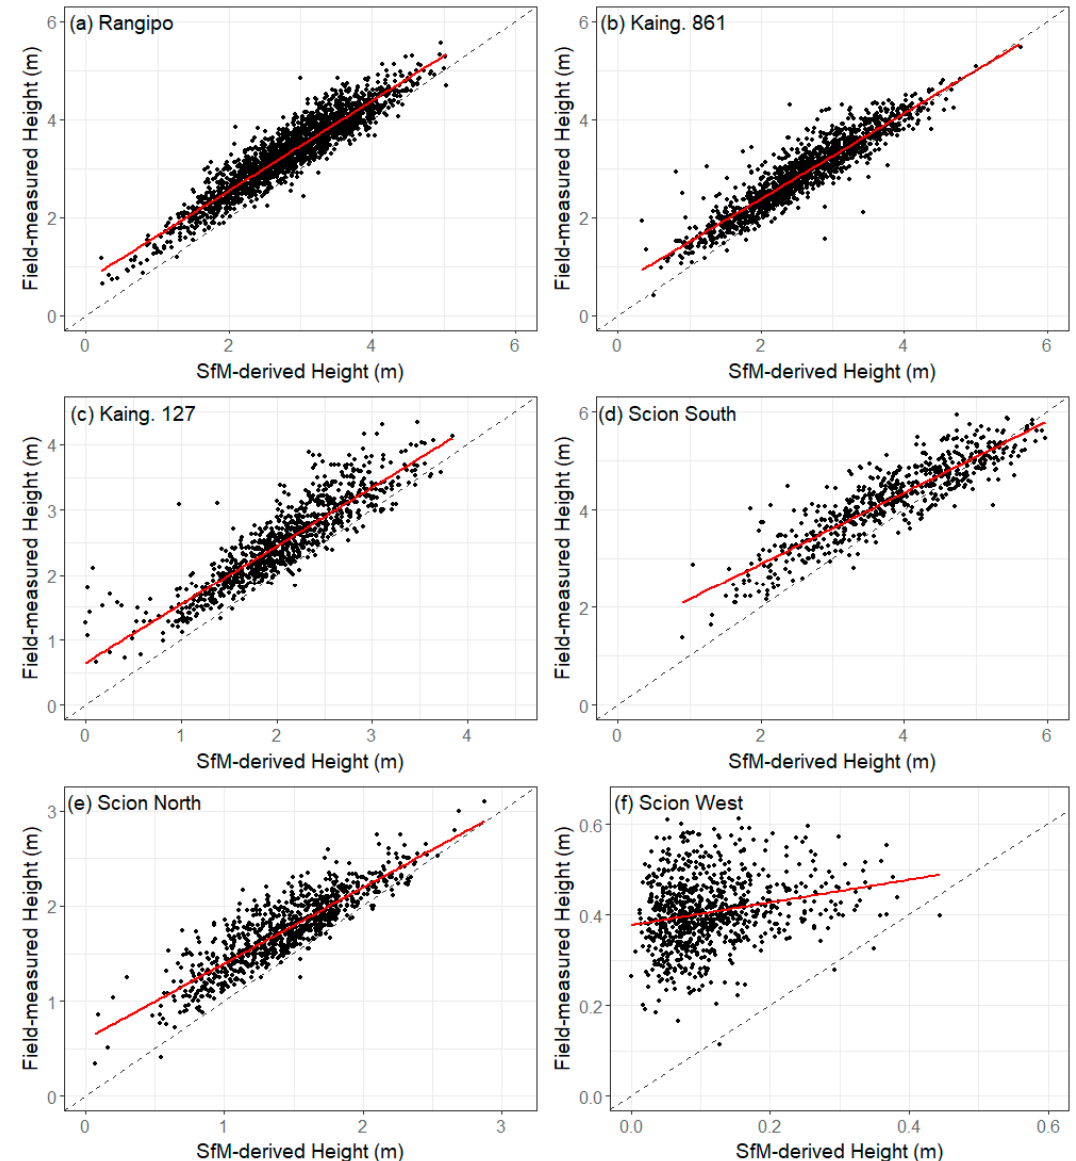
Figure 6. The relationship between field-measured and SfM-derived tree heights for ( a ) Rangipo, ( b ) Kaingaroa 861, ( c ) Kaingaroa 127, ( d ) Scion, South, ( e ) Scion, North and ( f ) Scion, West. Note the different y-axis scales between panels. The 1:1 line is shown as a dashed black line and a linear model fitted through the data is shown as a solid red line.